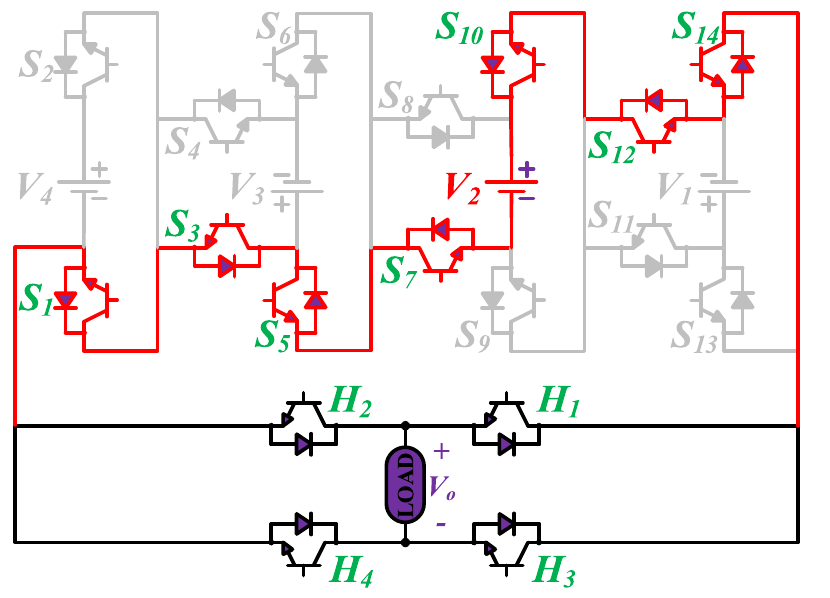
Fig 4. Switching states for voltage magnitude level